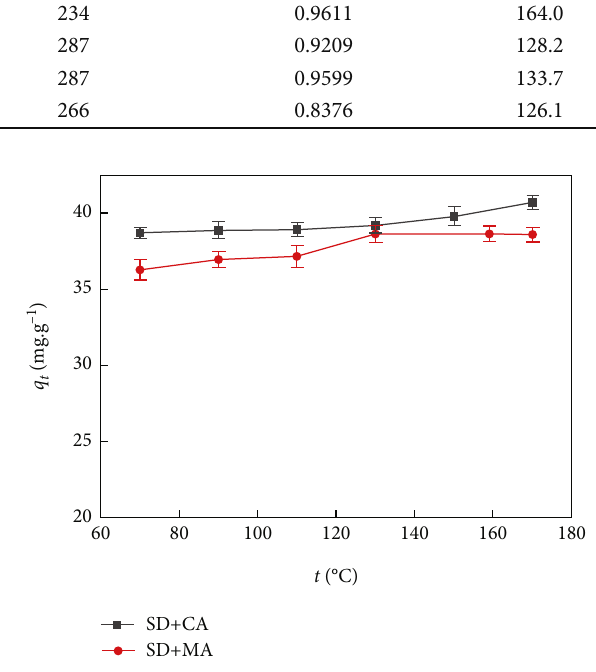
Figure 5: The e ff ect of drying temperature on boron adsorption capacity on SD +MA and SD+ CA.